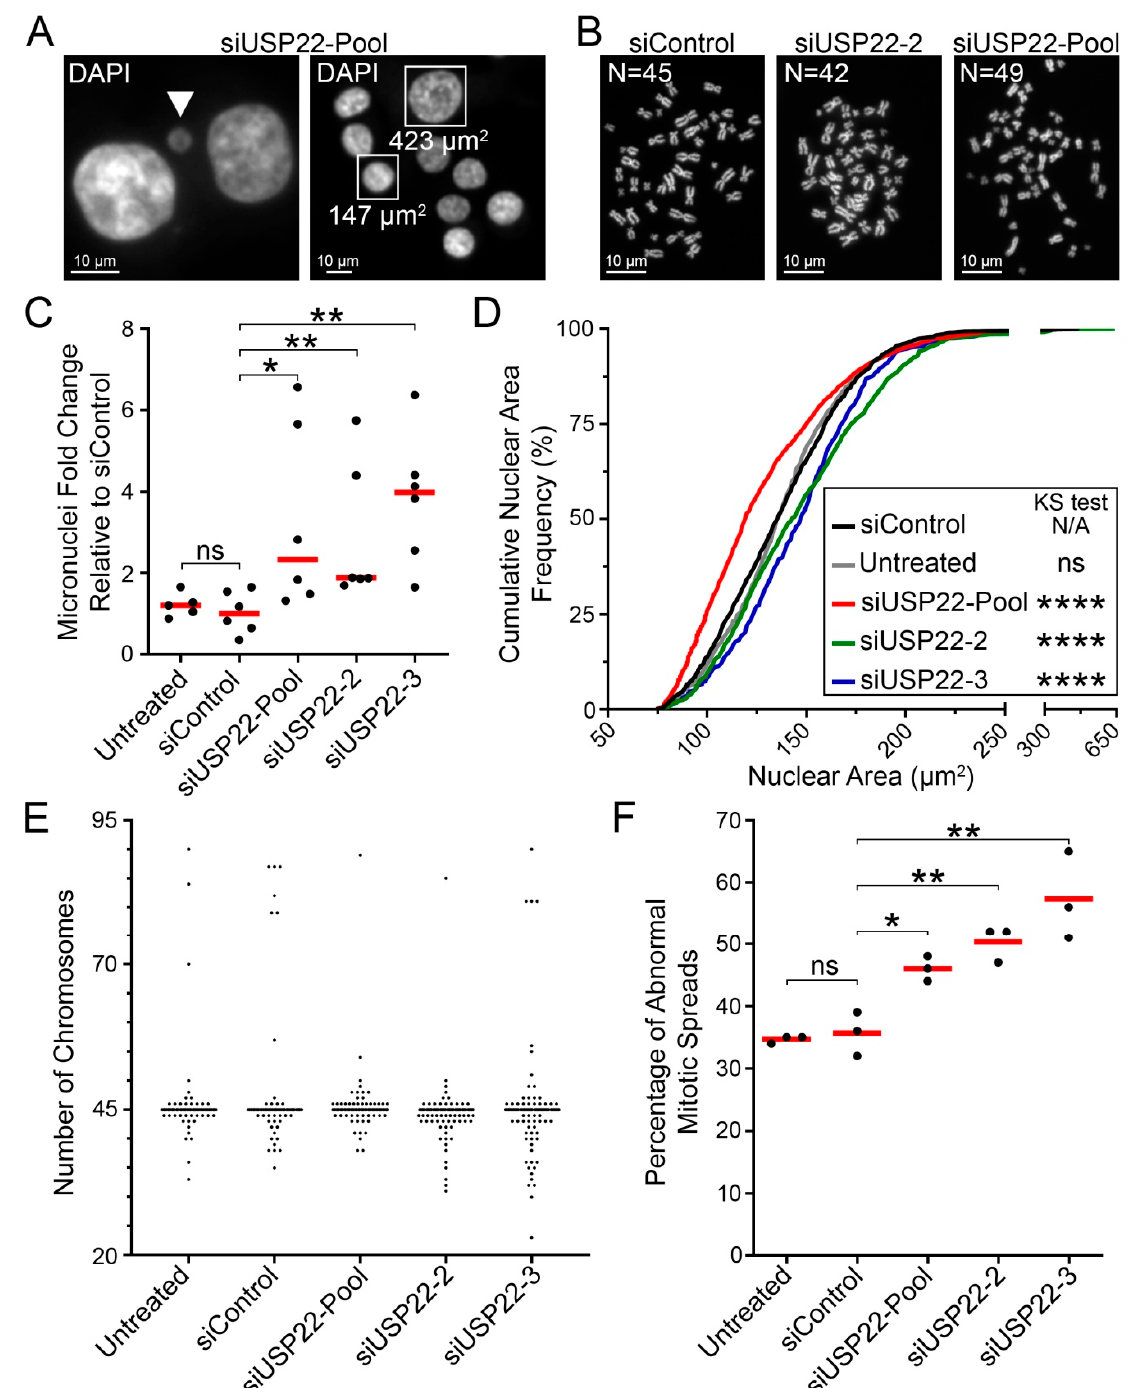
Figure 4. USP22 silencing induces CIN phenotypes in HCT116. ( A ) Representative images of USP22 -silenced nuclei displaying a micronucleus (left, arrowhead) and nuclear area heterogeneity (right). Bounding boxes identify two nuclei for which the respective areas are indicated. ( B ) Representative images of mitotic chromosome spreads exhibiting normal (left) chromosome numbers, losses (middle) and gains (right). Note that the modal chromosome number is 45 for HCT116. ( C ) Dot plot presenting the fold change in micronucleus formation relative to the median of siControl; red bars identify median values. Mann–Whitney tests identify statistically significant increases in micronucleus formation fol- lowing USP22 silencing relative to siControl (N = 2; n ≥ 5; minimum 100 nuclei analyzed/replicate; ns [not significant] p -value > 0.05; * p -value < 0.05; ** p -value < 0.01). ( D ) Two-sample KS tests reveal significant changes in cumulative nu- clear area distribution frequencies following USP22 silencing relative to siControl (N = 2; minimum 600 nuclei ana- lyzed/condition; N/A not applicable; ns p -value > 0.01; **** p -value < 0.0001). ( E ) Representative dot plot presenting the number of chromosomes enumerated from 100 mitotic chromosome spreads/condition (N = 3). An increase in the fre- quency of chromosome losses (N < 45) and gains (N > 45) is observed following USP22 silencing. ( F ) Dot plot showing frequency of abnormal mitotic chromosome spreads (N ≠ 45) following USP22 silencing relative to controls. Experiments